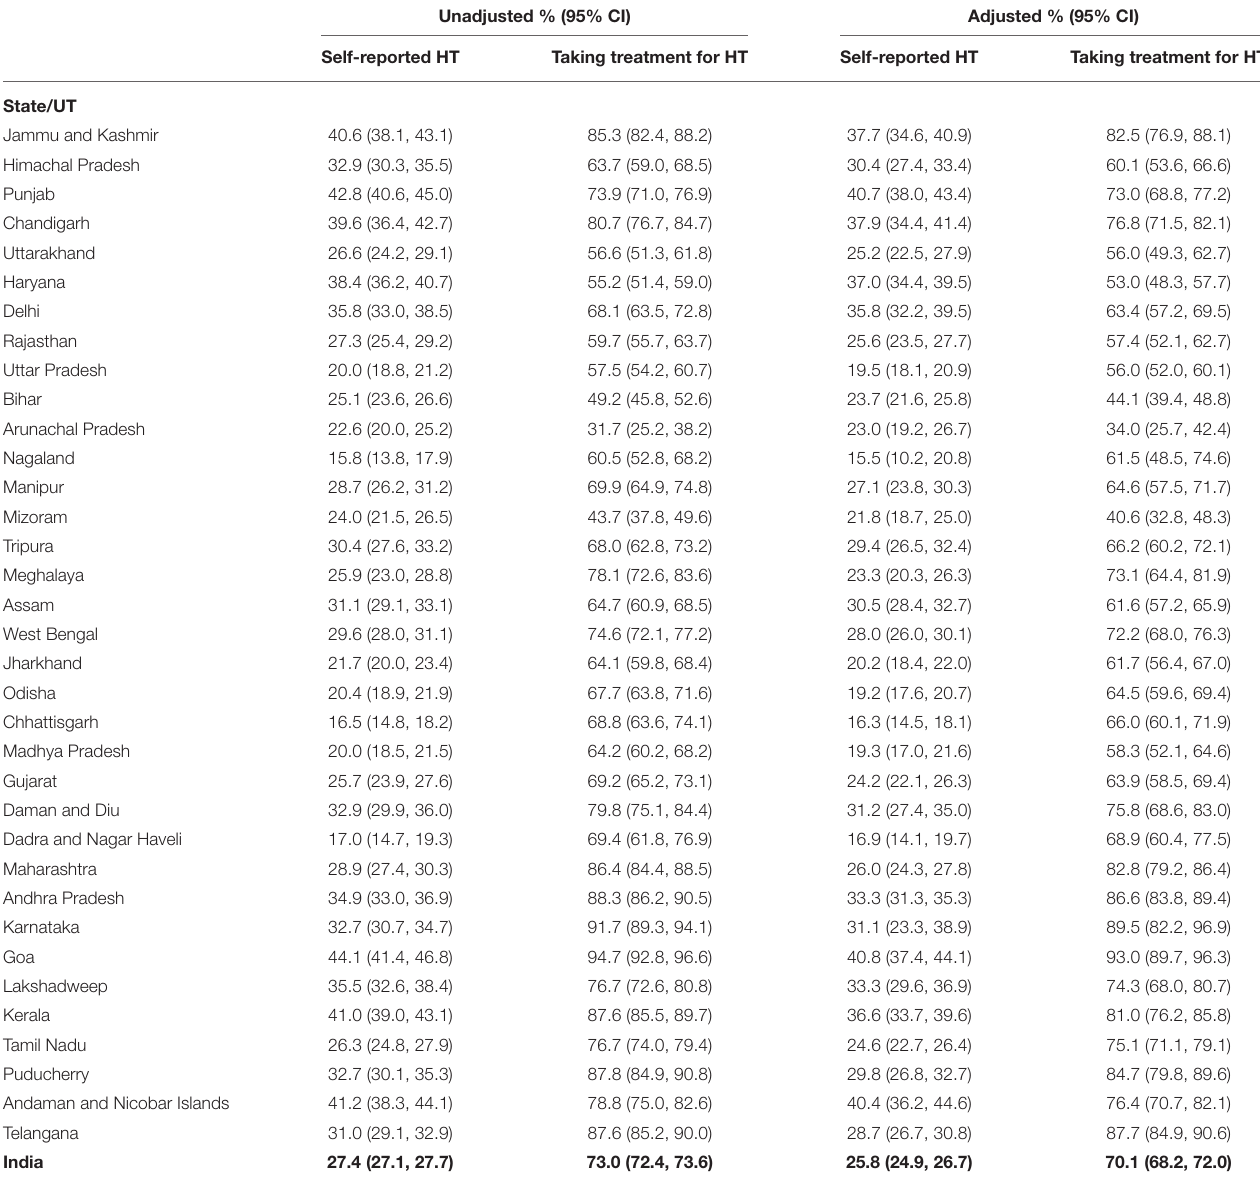
TABLE 1 | Unadjusted and age-sex adjusted prevalence of self-reported and its treatment, India, LASI, 2017–18. Unadjusted % (95% CI) Adjusted % (95% CI) Self-reported HT Taking treatment for HT Self-reported HT Taking treatment for